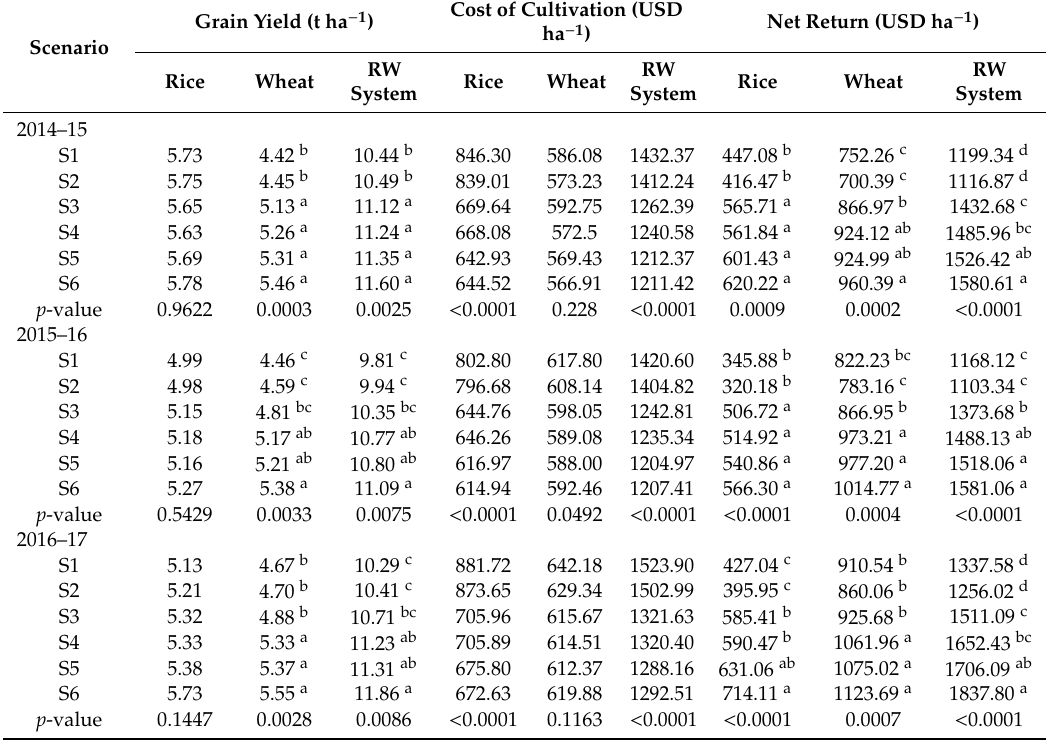
Table 6. E ff ect of di ff erent portfolios on yield and economics of rice, wheat and rice-wheat system under divergent crop management scenarios during the 3-year study